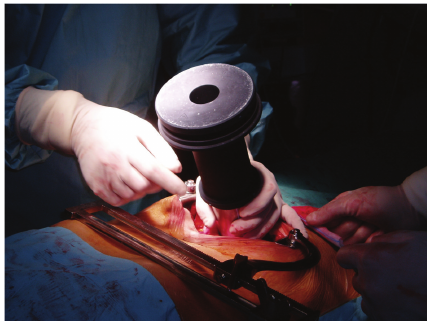
Figure 1: The appropriate collimator is placed and beam energy is chosen in order to include the prostate gland and the surrounding soft tissues with a suitable margin of 0.5–1 cm.